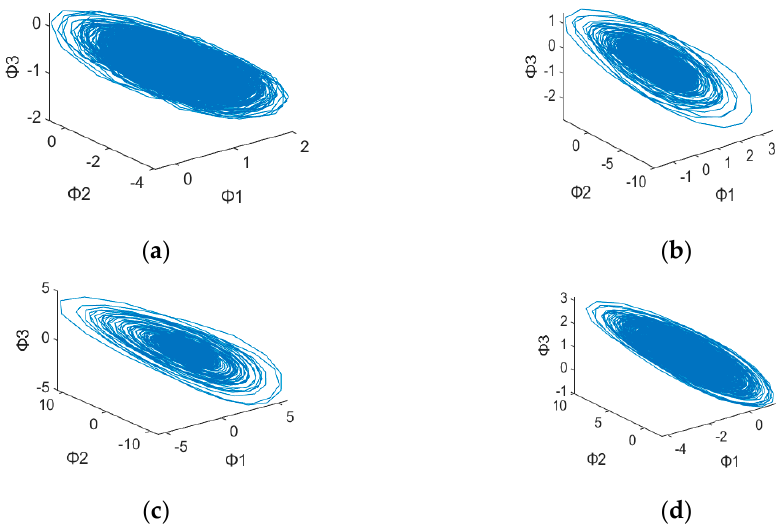
Figure 7. 3D dynamic error phase diagram of ball bearing under testing, with α = 0.3, HP = 0, and SPOF diameter = 0.014 in. ( a ) Normal state. ( b ) Ball fault. ( c ) Inner race fault. ( d ) Outer race fault.